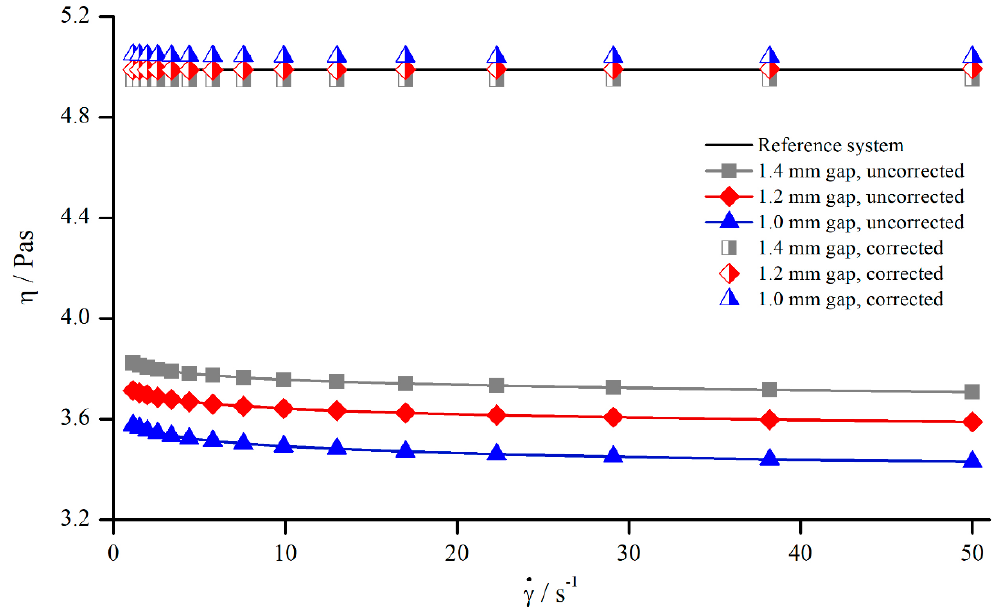
Figure 7. Uncorrected, corrected, and reference viscosity from silicon oil AK 5000, measured with pyramids (system 2).